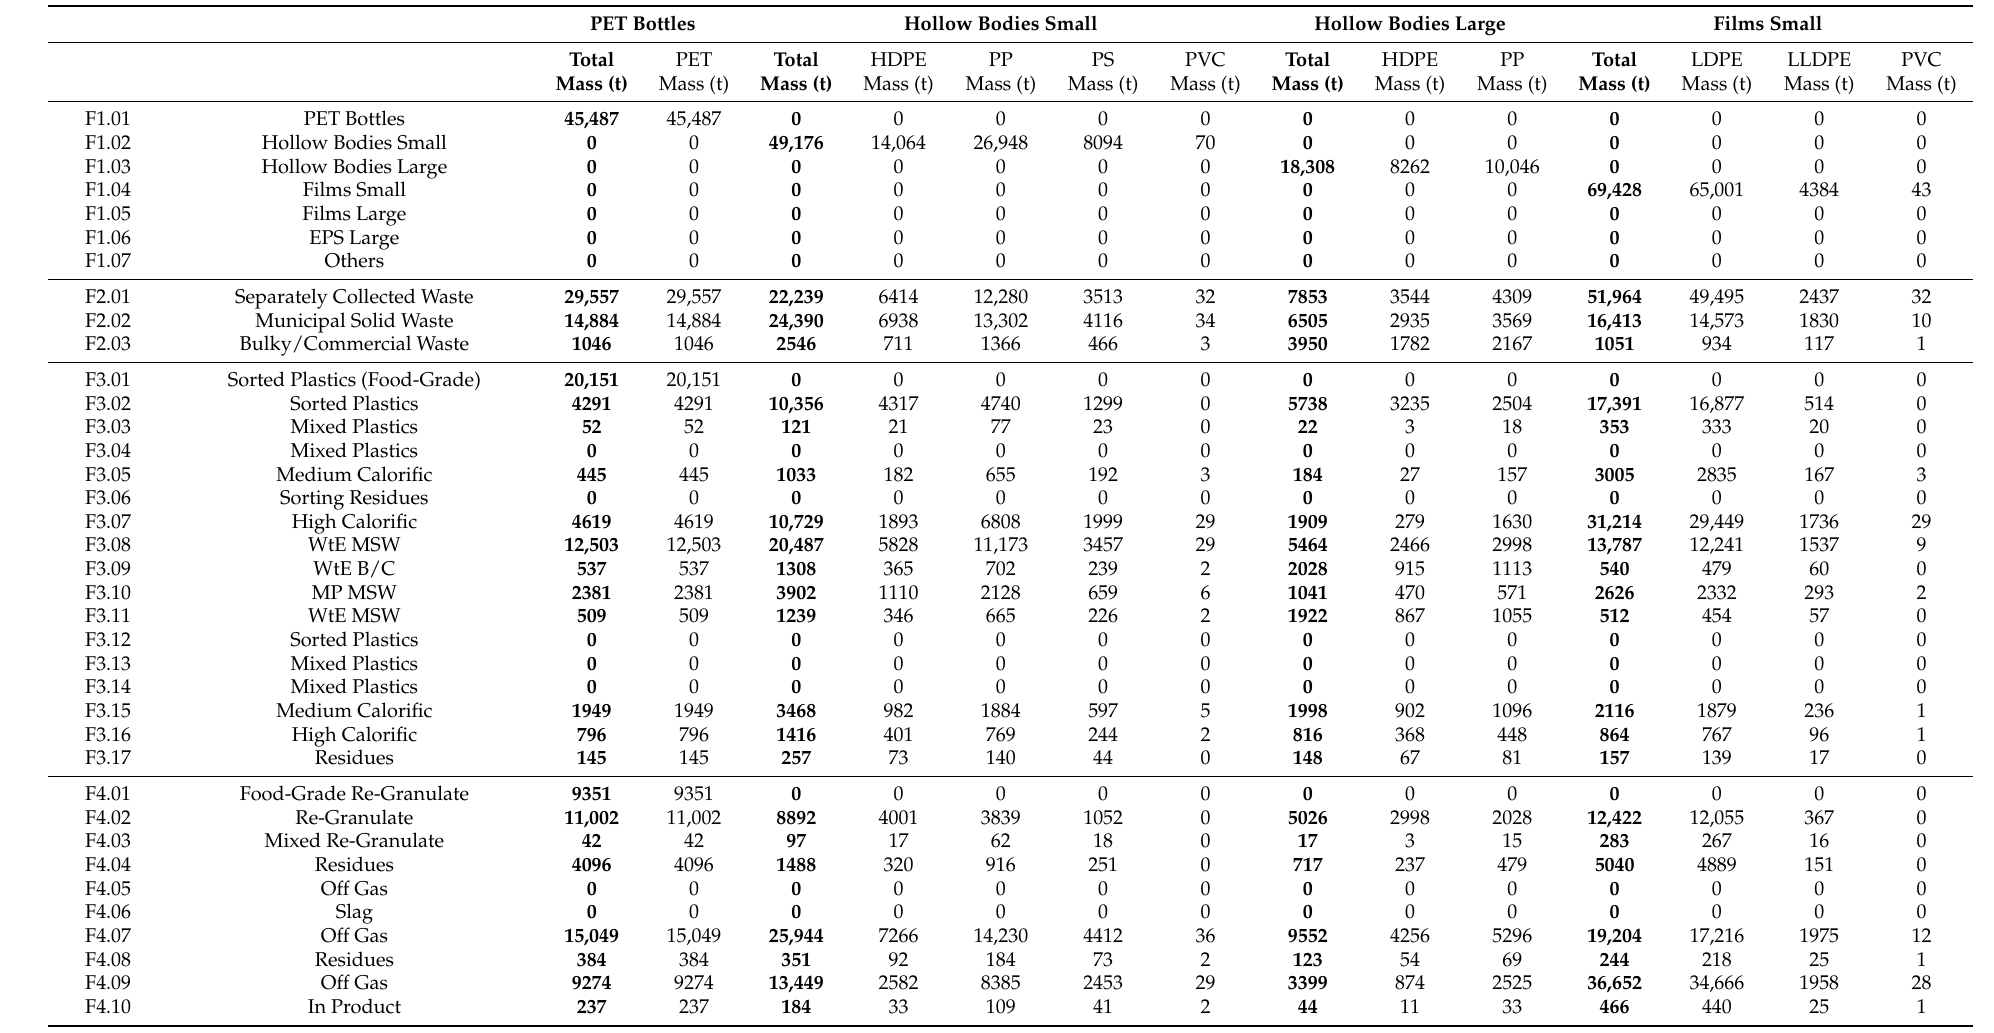
Table A4. Excerpt of the mass flow analysis results